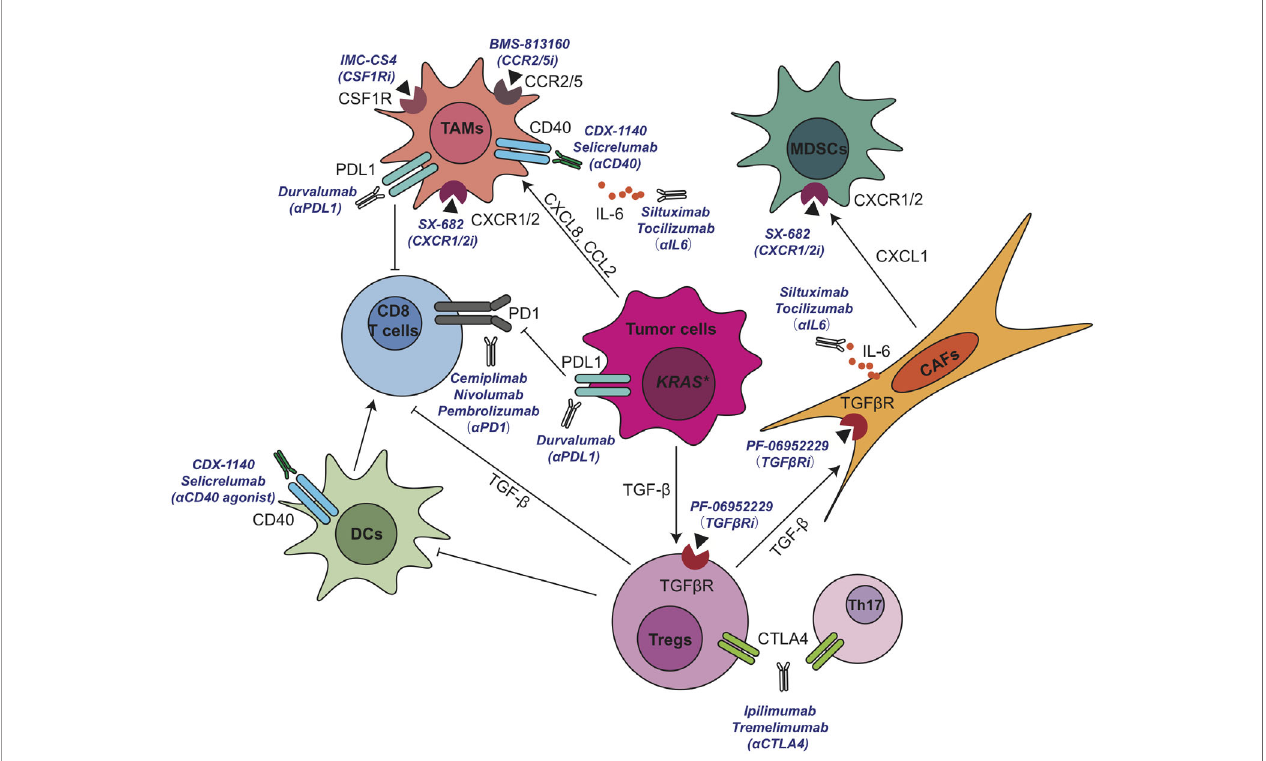
FIGURE 4 | Current active clinical trials targeting immunosuppressive TME in pancreatic cancer. CAF, cancer associated fi broblasts; CCL, C-C motif chemokine ligand; CCR, C-C motif chemokine receptor; CSF1R, colony-stimulating factor 1 receptor; CXCL, C-X-C motif chemokine ligand; DC, dendritic cell; IL, interleukin; MDSCs, myeloid-derived suppressor cells; PD-1, anti-programmed cell death 1; PD-L1, programmed cell death ligand 1; TAMs, tumor associated macrophages; TGF- b , transforming growth factor b ; Th, T helper; Tregs, regulatory T